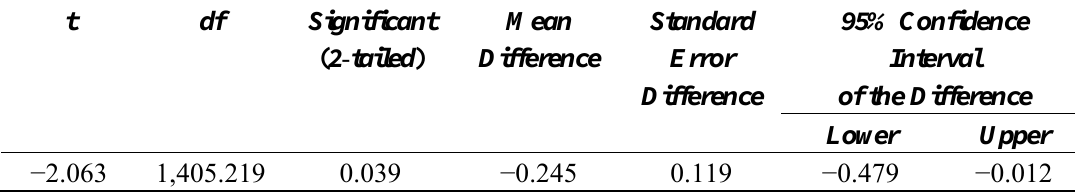
Table 6. T - test on sentiment of posts linking photos vs . videos (H3).